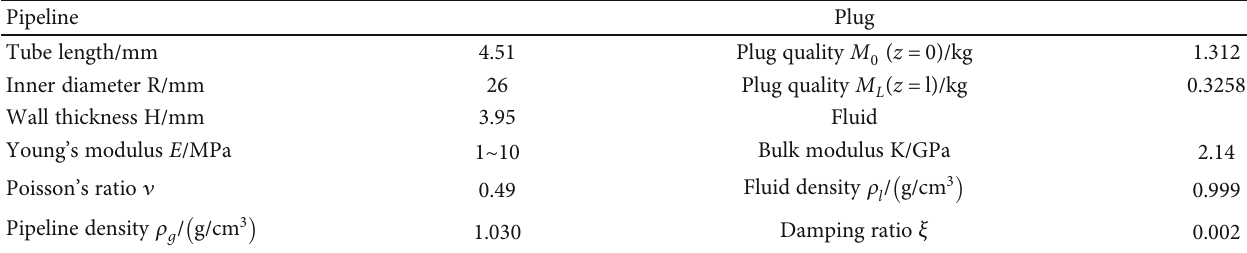
Table 2: Bionic pipeline and fl uid physical parameters.